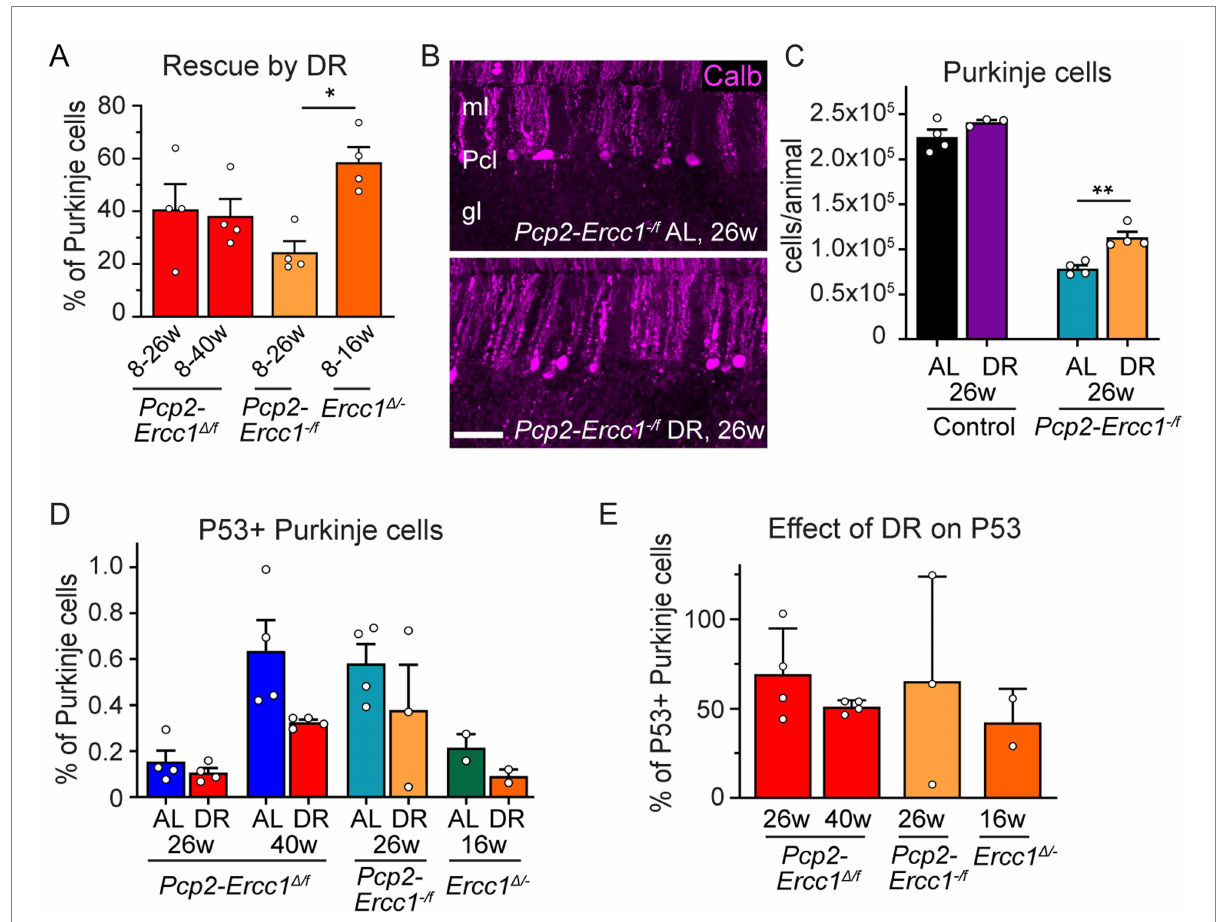
FIGURE 3 Differential protective effects of DR in Purkinje cell-specific and ubiquitous ERCC1-deficient mice. (A) Relative rescue of Purkinje cells by DR in Purkinje cell-specific ( Pcp2 - Ercc1 Δ /f and Pcp2 - Ercc1 −/f ) and global ( Ercc1 Δ /− ) mice, calculated by dividing the difference in Purkinje cell loss between DR and AL animals by the loss showed in AL mice. ( n = 4 per group); * p < 0.05 (One-way ANOVA; Tukey’s post-tests). (B,C) Representative confocal images (B) and bar graph (C) illustrating Purkinje cell degeneration in AL and DR Pcp2 - Ercc1 −/f mice. ( n = 4 per group) ** p < 0.01 (One-way ANOVA; Tukey’s post-test). (D) Bar graph of the proportion of Purkinje cells with P53-immunoreactive nuclei in ERCC1-deficient mouse mutants ( n ≥ 2 per group). Impact of DR across all groups: p = 0.024 [2-way ANOVA F (1,16) = 6.019]; DR-AL pair comparisons: p = 0.0784 in AL vs. DR Pcp2- Ercc1 Δ /f